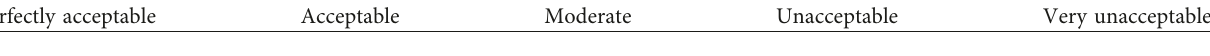
Perfectly acceptable